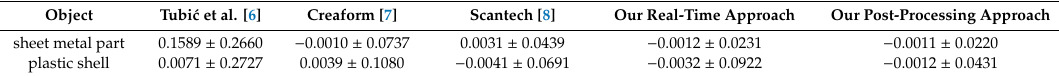
Table 4. C2M error statistics (mean ± Std.) for the random samples of di ff erent methods.